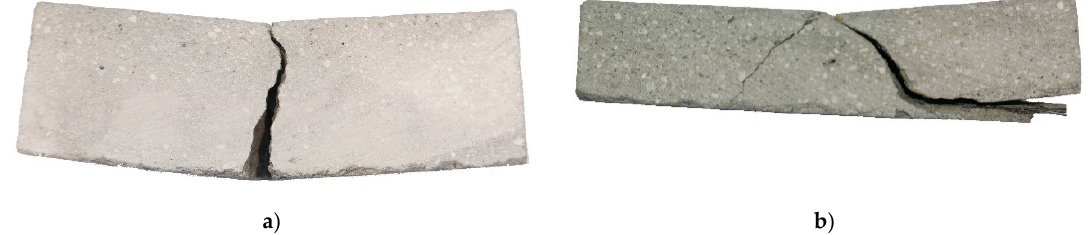
Figure 14. Tested specimens with cross-section of a ) 40 mm x 40 mm and b ) 20 mm x 25 mm.